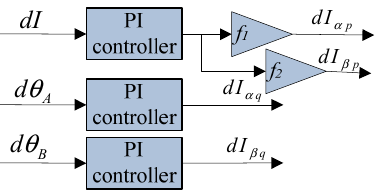
Figure 9. A simple PI controller that compensates for RPC.